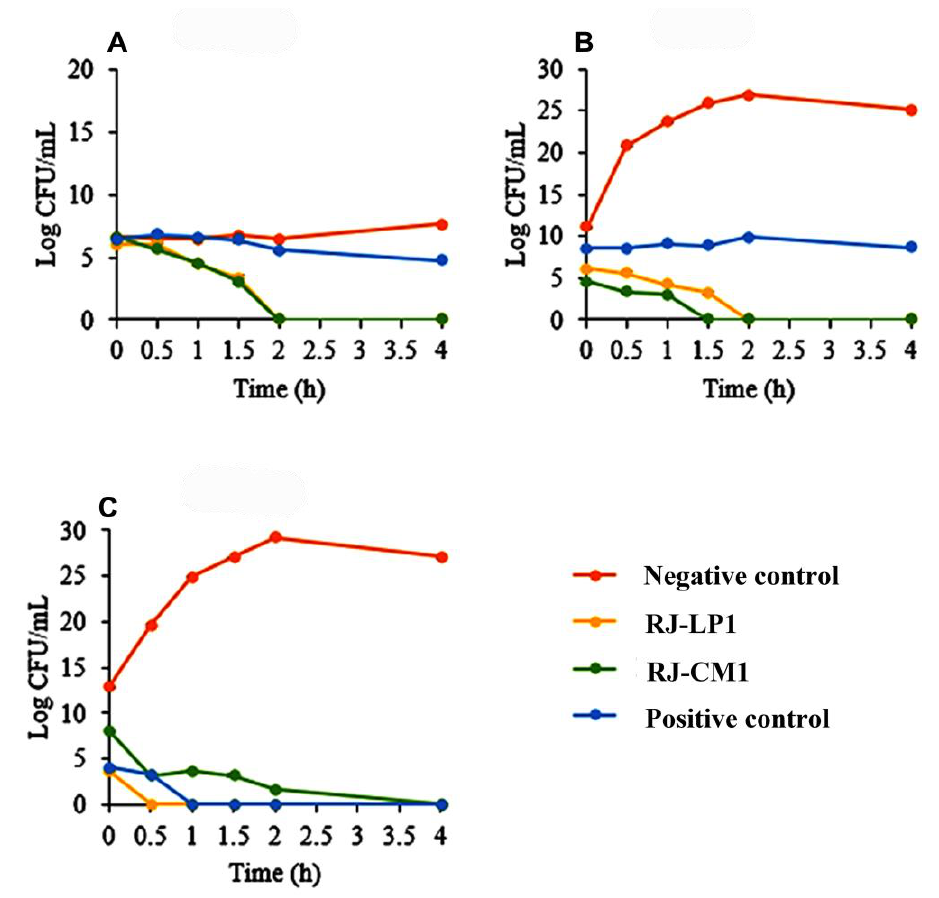
Figure 1. Time killing curve of royal jelly samples RJ-LP1 and RJ-CM1 on C. acnes ( A ), MRSA ( B ) and S. aureus ( C ). Time-kill data represented as mean ± SD ( n = 3). The negative control contained the medium without royal jelly. Gentamicin at 0.0039 mg/mL and 0.0156 mg/mL was used as the positive control for C. acnes and S. aureus , respectively. Vancomycin at 0.0020 mg/mL was used as the positive control for MRSA.